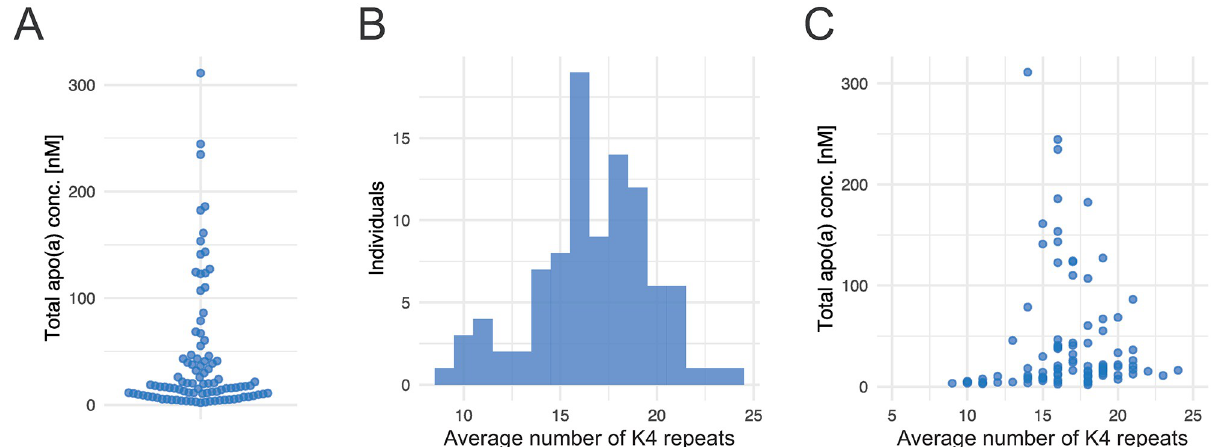
Fig 4. Apolipoprotein plasma profiling of 90 individuals. A) Beeswarm plot visualizing the total apo(a) levels among the 90 profiled subjects determined by the peptide EAQLLVIENEVCNHYK. B) Histogram of the average number of K4 domains present in the profiled samples, determined by the peptide GTYSTTVTGR. C) The average number of K4 repeats plotted against the total plasma concentration of apo(a).